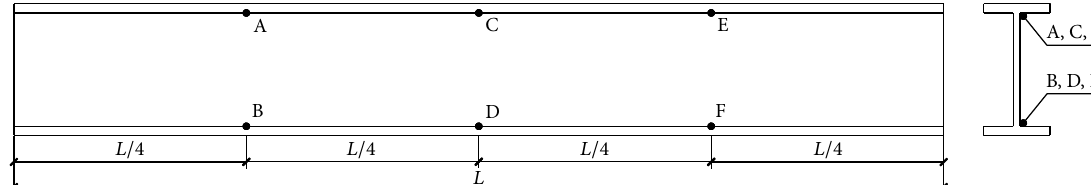
Figure 23: Location of